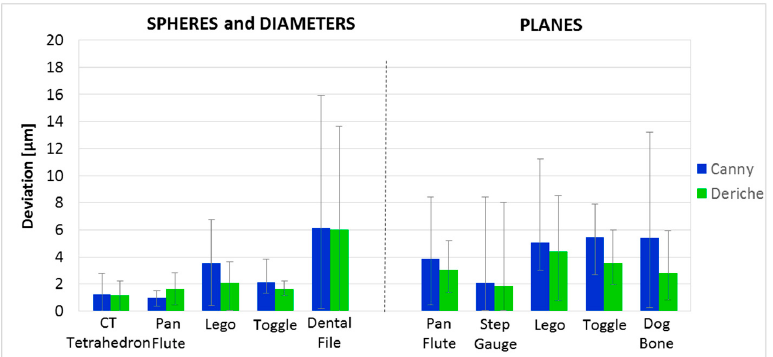
Figure 9. Average deviation for the Canny-based method (blue bars) and Deriche-based method (green bars) and maximum and minimum deviation (error bars) of all the part dimensions from their calibrated absolute values of single material parts grouped by dimension type.